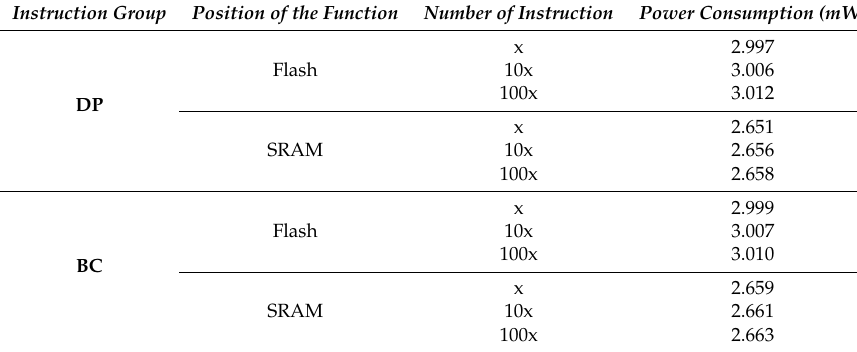
Table 3. Power consumption based on code profiling